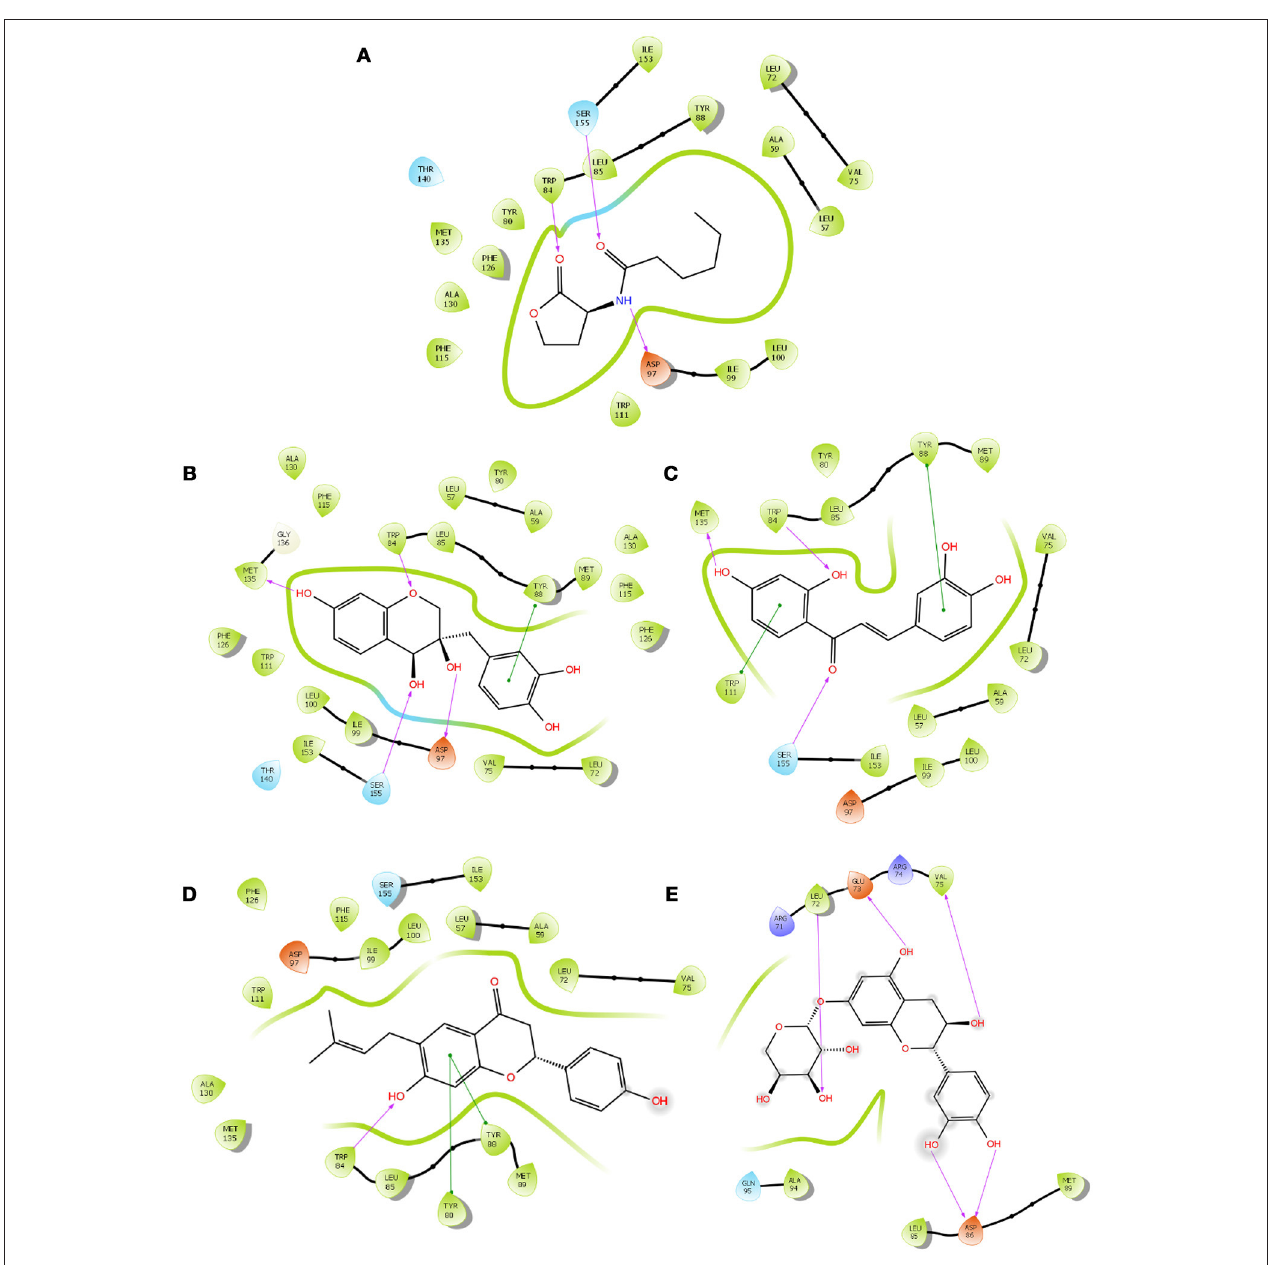
FIGURE 1 | The 2D interaction diagrams of QSIs against CviR. The purple arrows shows the H-bonds whereas the green lines shows the π - π stacking. (A) is for interaction map of C 6 HSL, (B) for interaction map of SPL, (C) for interaction map of BN1, (D) for interaction map of BN2 and (E) for interaction map of C7X against CviR. Most of the QSIs have at least one common bond forming aminoacid with C 6 HSL (Trp 84, Asp 97, Ser 155) and all of them have least GScore than C 6 HSL.